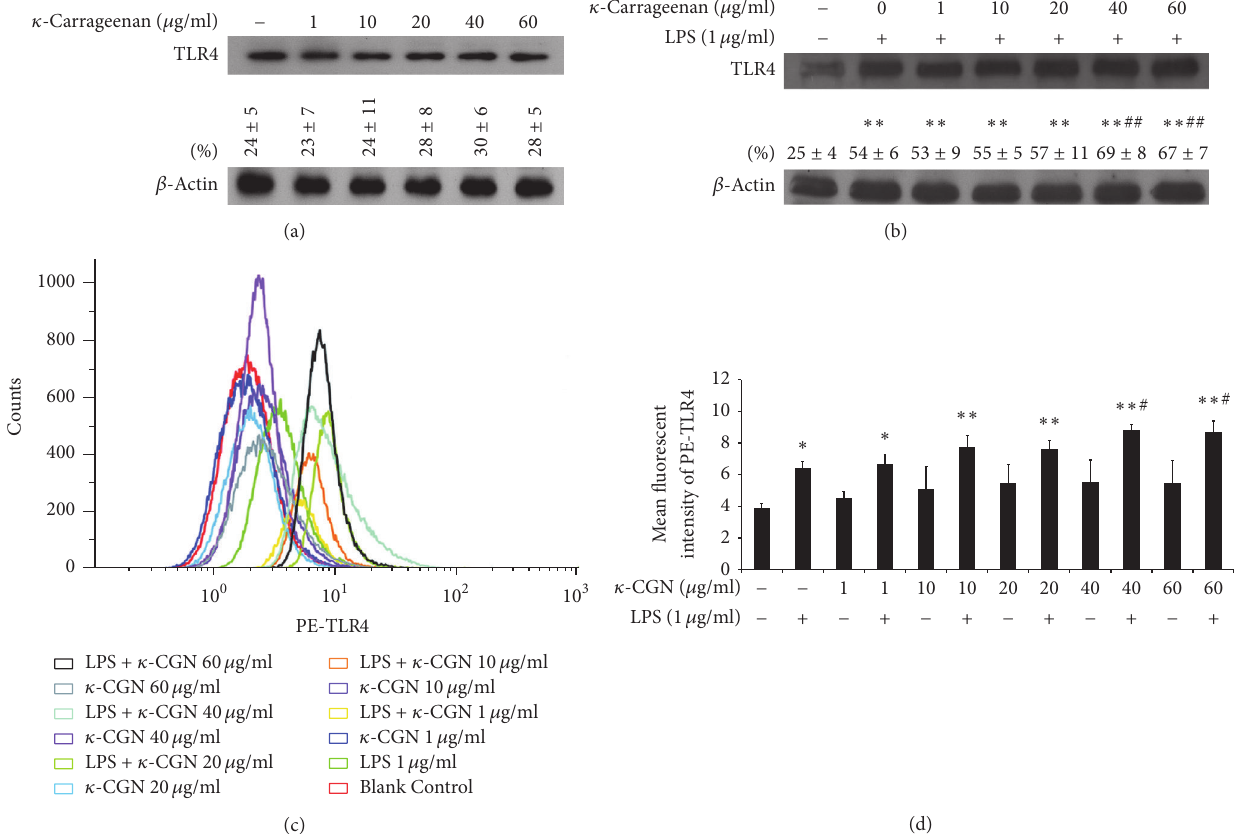
Figure 2: 𝜅 -Carrageenan enhances LPS-induced TLR4 expression in HT-29 cells. (a) The effect of 𝜅 -carrageenan on the expression of TLR4 in HT-29 cells. (b) 𝜅 -Carrageenan increased LPS-induced expression of TLR4. Cells were treated with 𝜅 -carrageenan for 24 h or were pretreated with 𝜅 -carrageenan for 1h and then with LPS (1 𝜇 g/mL) for 24 h. (c) TLR4 expression in HT-29 cells is affected by 𝜅 -carrageenan. Cells were treated with 𝜅 -carrageenan for 24 h and then were incubated with 1 𝜇 g PE-TLR4 for 25 min. ∗ 𝑃 < 0.05 , ∗∗ 𝑃 < 0.01 , compared with the blank group. # 𝑃 < 0.05 , ## 𝑃 < 0.01 compared with those in the LPS alone treated group.compared with the LPS treated alone. (d) 𝑦 -axis shows the mean fluorescent intensity of